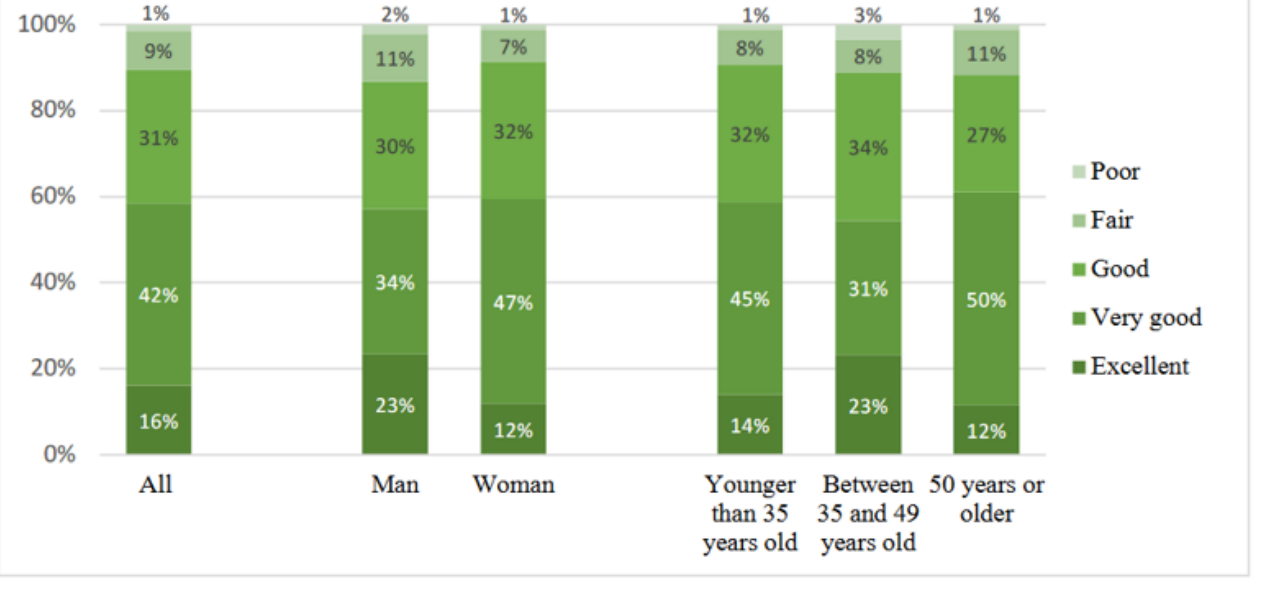
Figure 2. General health during COVID-19 by gender and age group, by percentage.